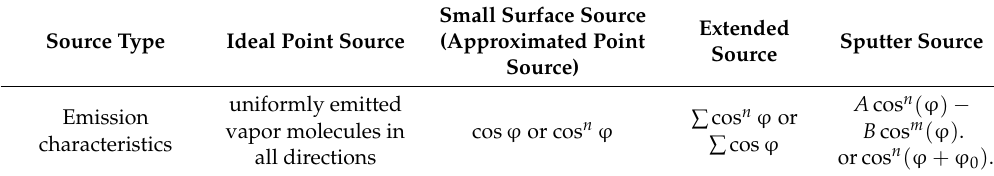
Table 1. Summary for emission characteristics of the source.